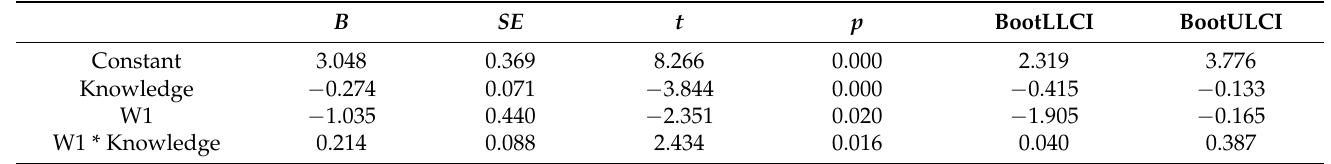
Table 6. Moderation effect of workplace safety perception in the relation between COVID-19 knowl- edge and anxiety.